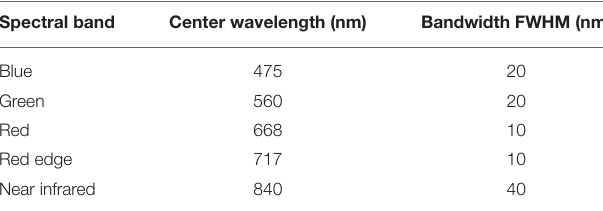
TABLE 1 | Center wavelength and full width at half maximum (FWHM) bandwidth of each spectral band of the RedEdge multispectral camera.